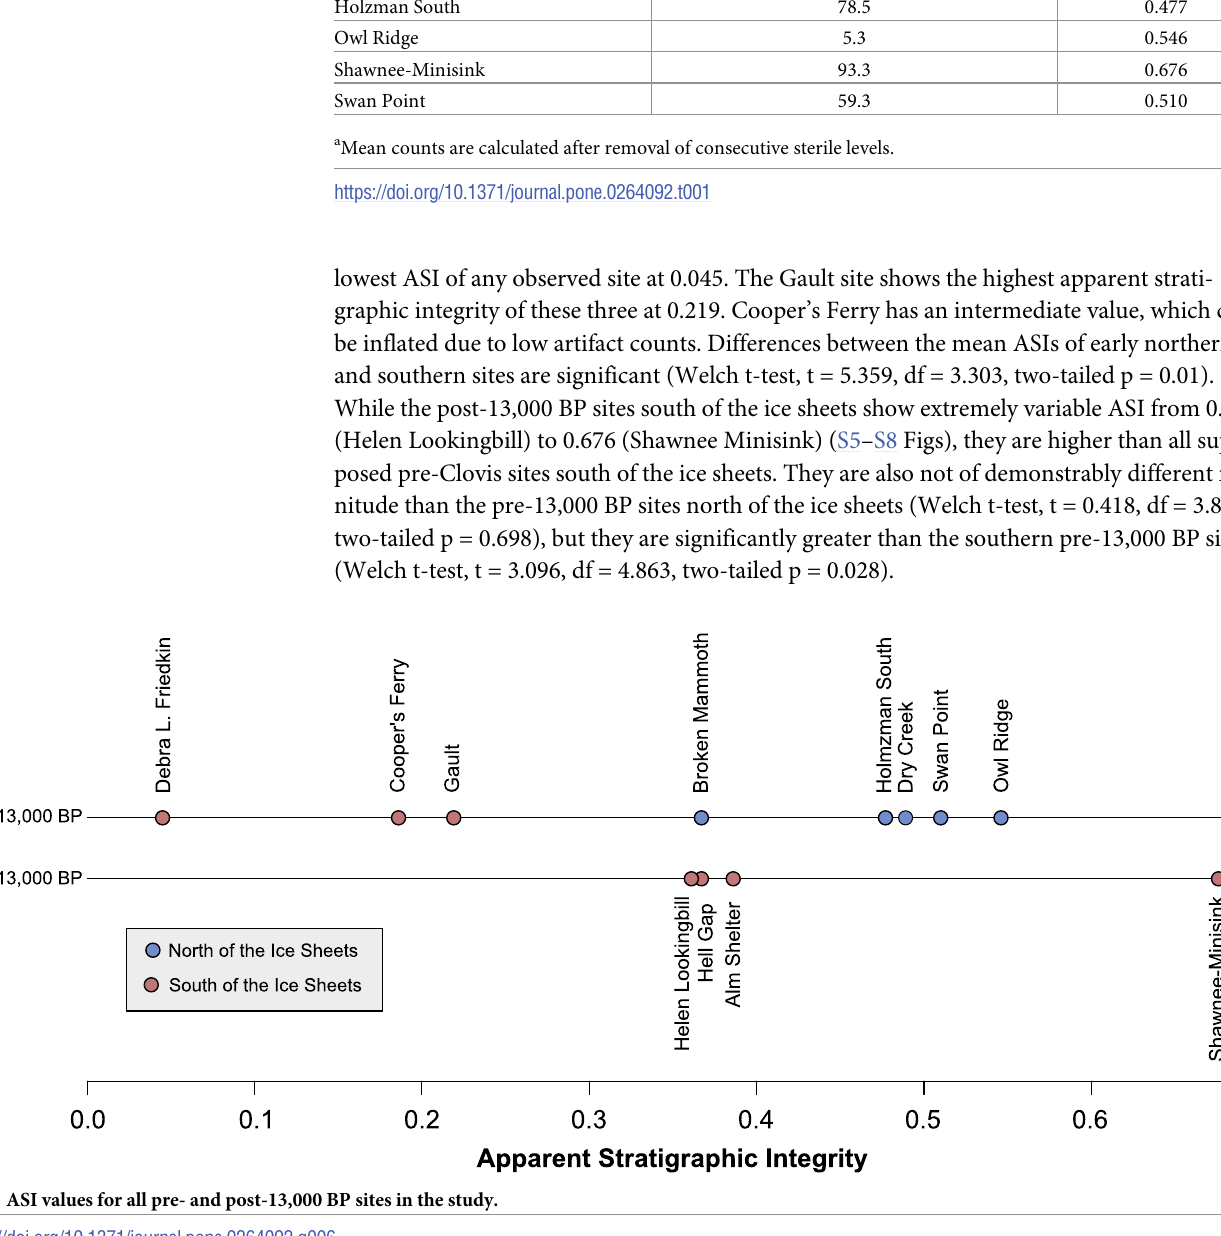
PLOS ONE | https://doi.org/10.1371/journal.pone.0264092 April 20,